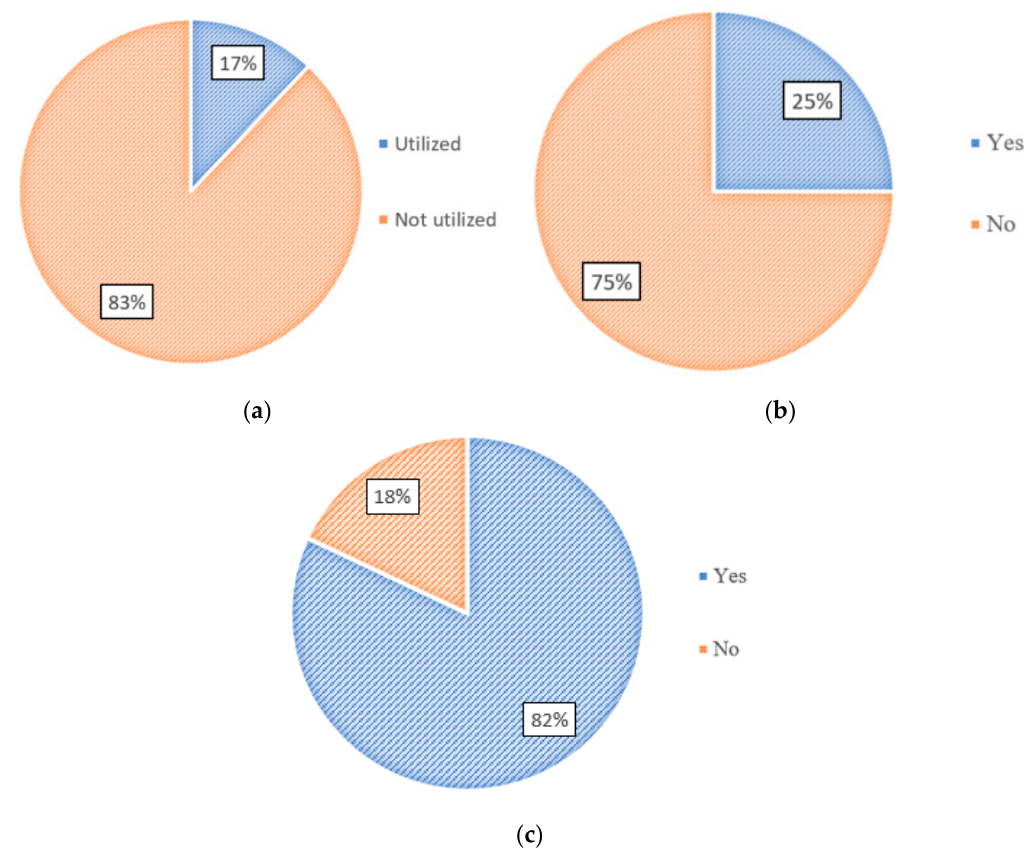
Figure 4. Implementation of BIM; ( a ) BIM utilization in projects; ( b ) BIM policies in the organizations; and ( c ) prediction about BIM.